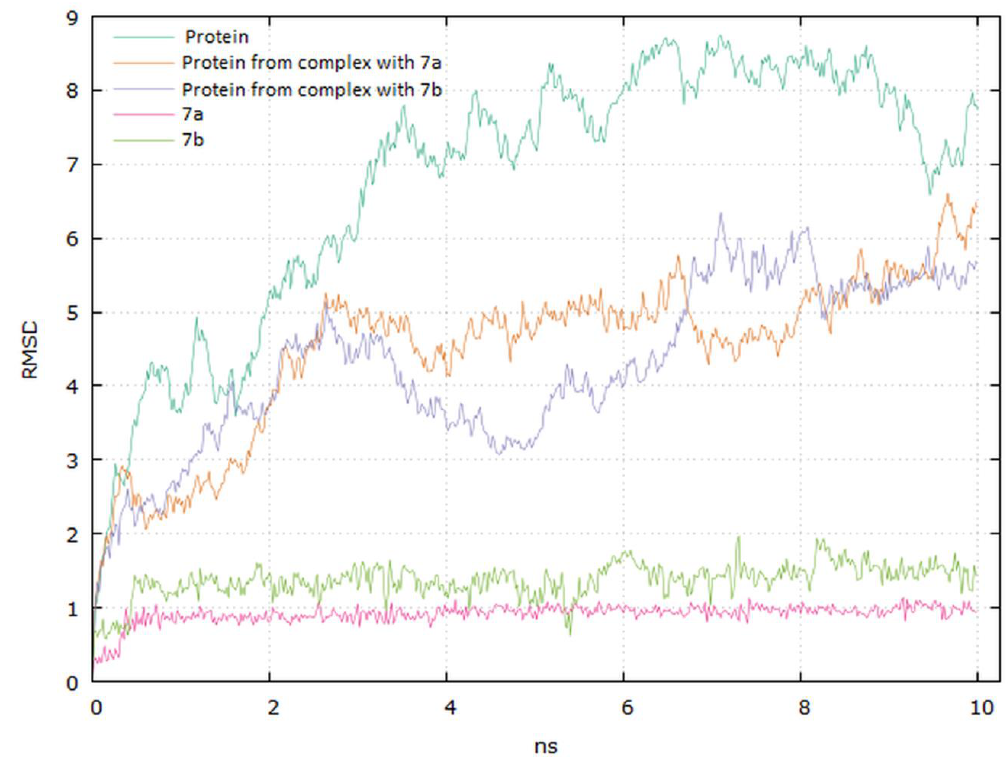
Figure 15. Graphical representation of the plots showing proteins C α RMSD (Å) and ligands atoms versus time (10 ns).